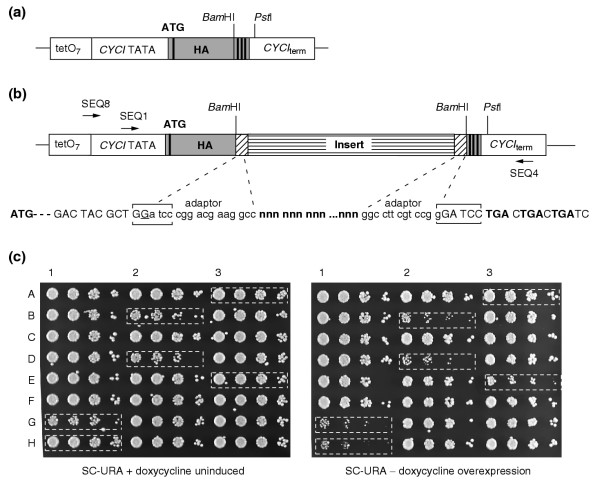
Overexpression library construction and screening. (a) Construction of an HA-tagged vector. The pCMha190 vector used here was constructed by insertion of a linker (gray box) in place of the multiple cloning site in vector pCM190 [31]. Features shown include the promoter and TATA box as well as the terminator from the original plasmid (open boxes), and the start codon, HA-tag, BamHI site and stop codons (thick vertical bars) from the introduced linker sequence. The linker was composed from the following annealed oligonucleotides: EXP3: 5'-GATCGTTTAAACCATATGTACCCATACGACGTCCCAGACTACGCTGG ATCCTGACTGACTGATC-3', EXP4: 5'-GGCCGATCAGTCAGTCAGGATCCAGCGT AGTCTGGGACGTCGTATGGGTACATATGGTTTAAAC-3'. (b) Library construction in pCMha190 (see Materials and methods for experimental details). The resulting ligation product is schematized, with the insert as a striped box and adaptors as hatched boxes. Sequences shown below are from junctions, with uppercase letters corresponding to vector (the extra nucleotide from filling-in is underlined), lowercase letters to adaptors and bold nnn's to insert. Arrows indicate the different primers used: SEQ8 and SEQ4 are used for PCR amplification of the insert, and SEQ1 for sequencing (see sequences in Additional data file 8). (c) First-round screening of toxic phenotypes. The growth of random and control clones on selective medium in uninduced and overexpression conditions is shown. Drops of serial dilutions (1/100 to 1/100,000) of cultures were grown for 45 h at 30°C. A3, non-toxic control clone transformed by pCMha190; H1, toxic control clone transformed by MCM1 gene cloned in pCMha190; G1, B2, D2, E3, library transformed clones, exhibiting different levels of toxicity in overexpression conditions (see Figure 2).